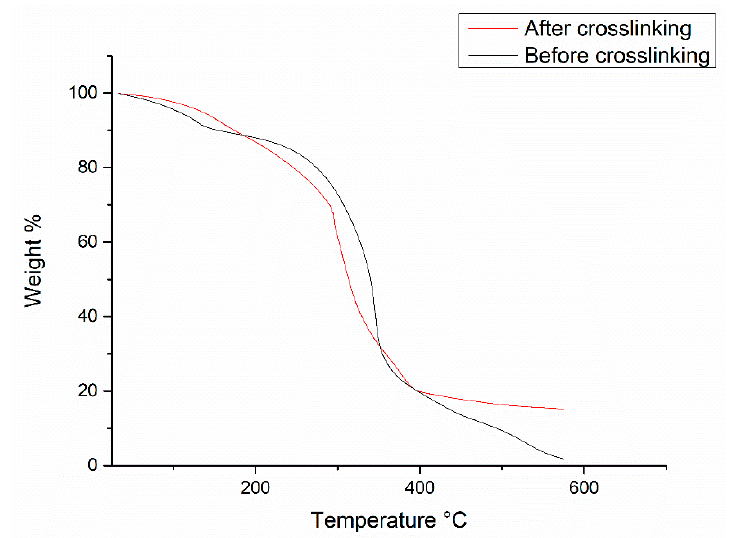
Figure 7. TGA thermograms of poly(VDF- ter -VTEOS- ter -VDMP) terpolymer ( P 20 , Table 1) before (blue curve) and after (red curve) crosslinking under air (heating-rate: 10 °C min − 1 ).